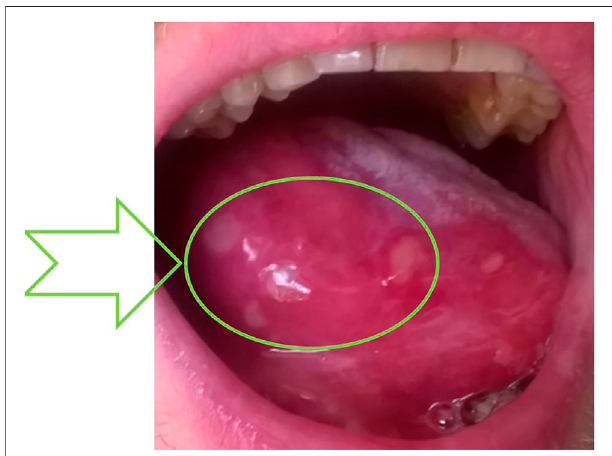
FIGURE 2 | WHO stage 3 of oral mucositis caused by dysbiosis after quadrupling fl uticasone therapy. Macroglossia — enlargement of the tongue with acute epithelial disruption with fi brin, called epithelitis — and many ulcers were observed as a sign of lymphocytic in fi ltration of the epithelia. Formation of a fi brin coating — the place of subsequent sampling (dysbiosis state) — is indicated by an arrow. The probable ADRs are reported as L453/